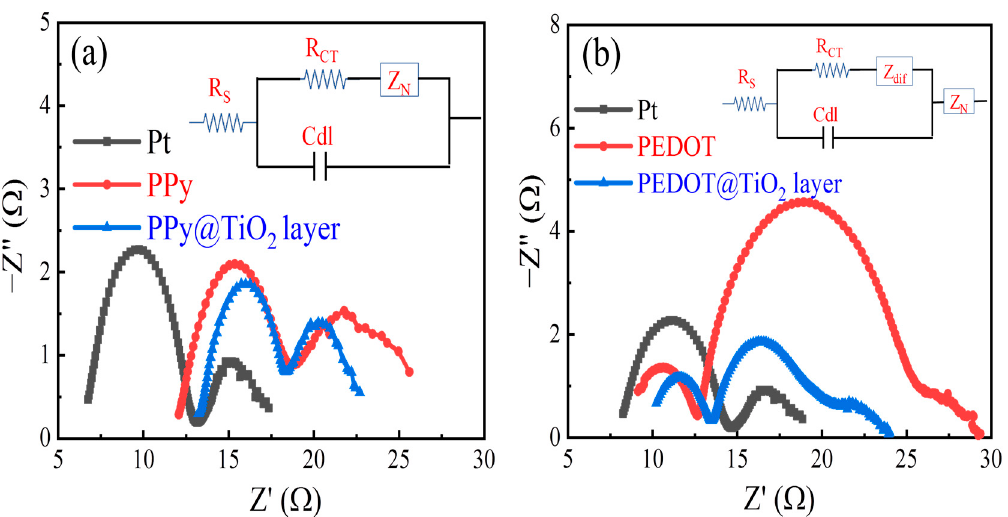
Figure 5. Nyquist plots of symmetric cells with ( a ) Pt, PPy, PEDOT, PPy@TiO 2 , and ( b ) Pt, PEDOT@TiO 2 CEs (The inside upper is the equivalent circuit used for fitting the Nyquist plots).